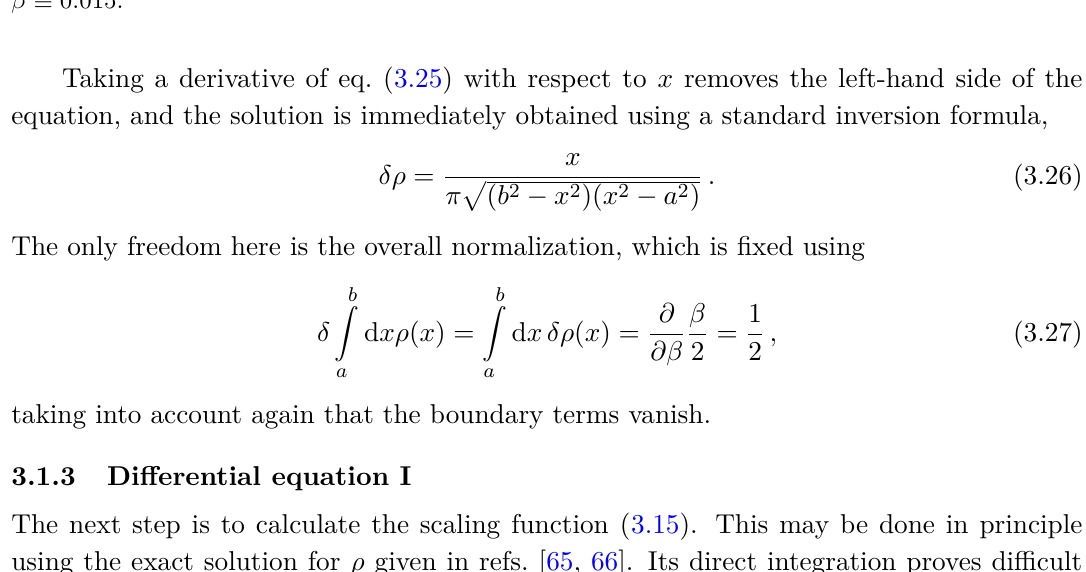
Figure 5 . Plot of the density ρ and shifted potential ˜ V ( x ) = 2 πx − log x + λ at low density β ≡ 0 . 015